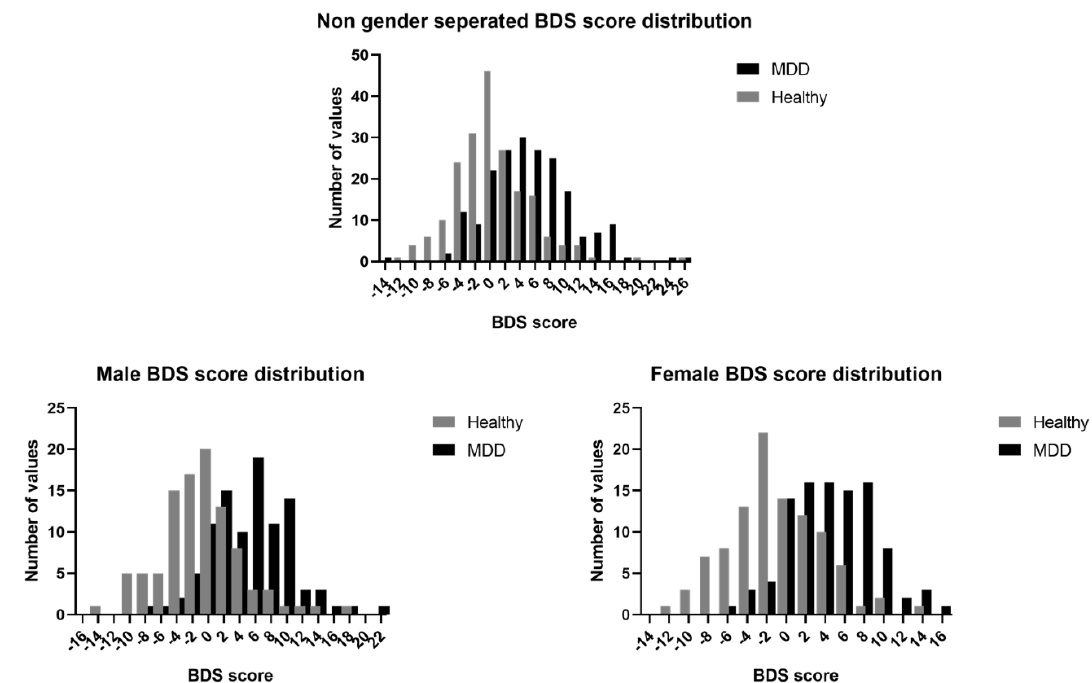
Figure 1. Bio depression score distribution with and without gender stratification. Each generated bio depression score (BDS) is based on all the actively contributing biomarkers within the quantile-based prediction (QBP) for each configuration.